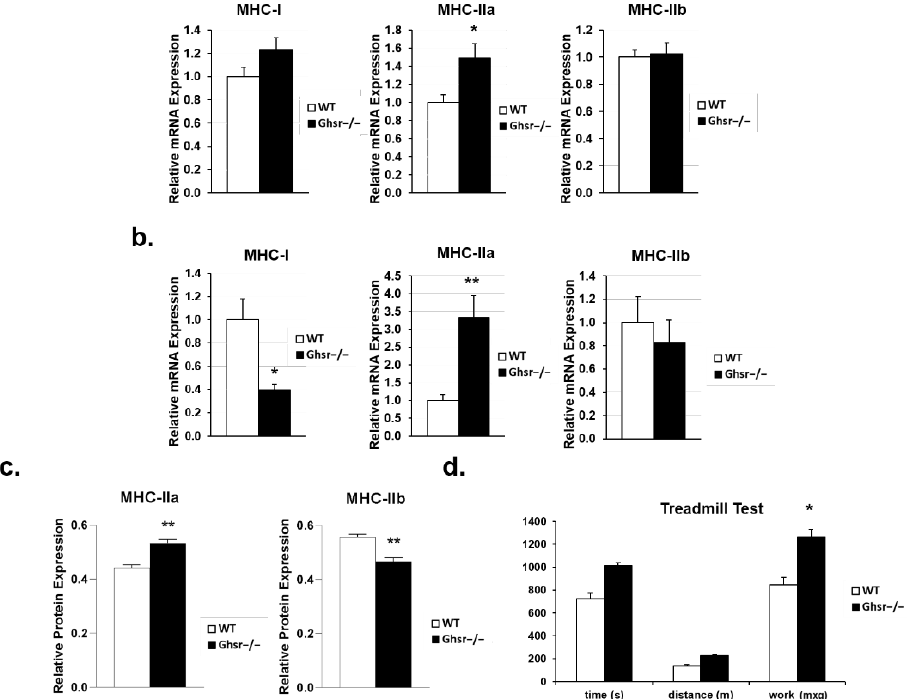
Figure 4. Expression of myosin heavy chain subtypes and treadmill work output of old Ghsr − / − mice. Old (16–24 m) WT (open bar) and Ghsr − / − (closed bar) mice were used in this set of experiments. ( a ) Relative mRNA expression of myosin heavy chain in gastrocnemius ( n = 9). ( b ) Relative mRNA expression of myosin heavy chain in soleus muscle ( n = 6). ( c ) Protein expression of myosin heavy chain isoforms of MHC-IIa and MHC-IIb relative to total Myosin heavy chain expression in old WT ( n = 4) and Ghsr − / − ( n = 3) mice. ( d ) Treadmill test—time, distance and work of old WT and Ghsr − / − mice ( n = 10). S: seconds of time; m: meters of distance; mxg: work performed during treadmill. 18s and β -actin house-keeping genes were used as internal controls in qPCR analysis. Two-tailed Student’s t -test were performed, and data are presented as means ± standard error. * p < 0.05, ** p < 0.001, Ghsr − / − . vs. WT.